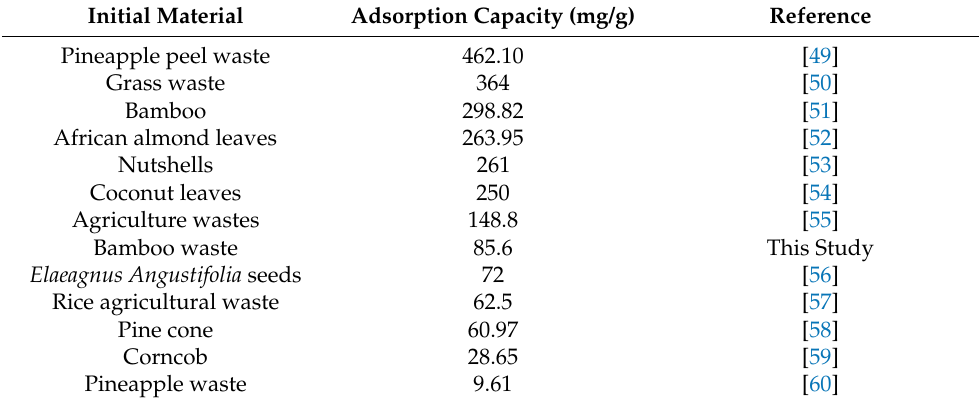
Table 8. Comparison study of activated carbon prepared from different materials.